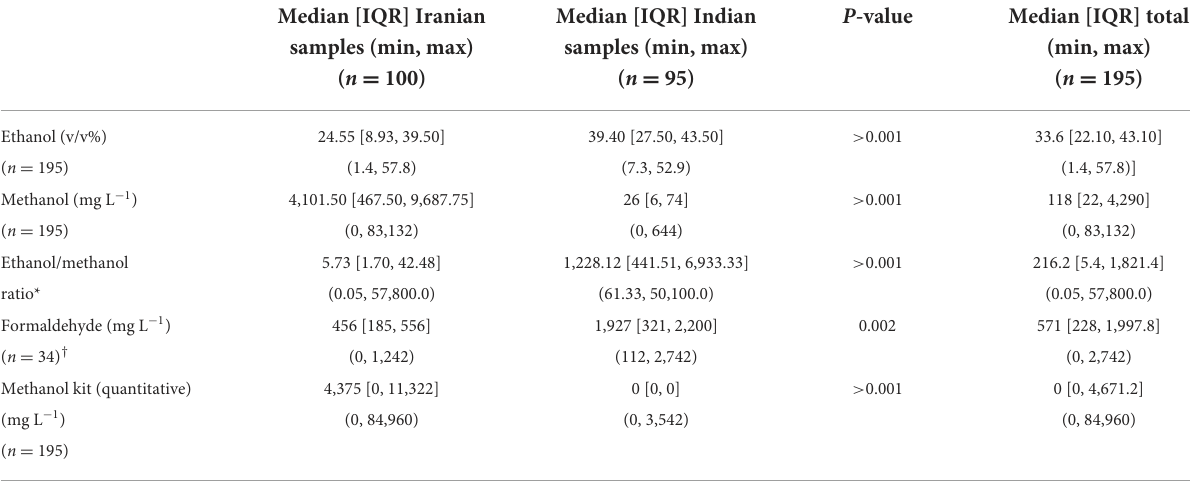
TABLE 1 Results of the measurements by different methods in Indian/Iranian samples.